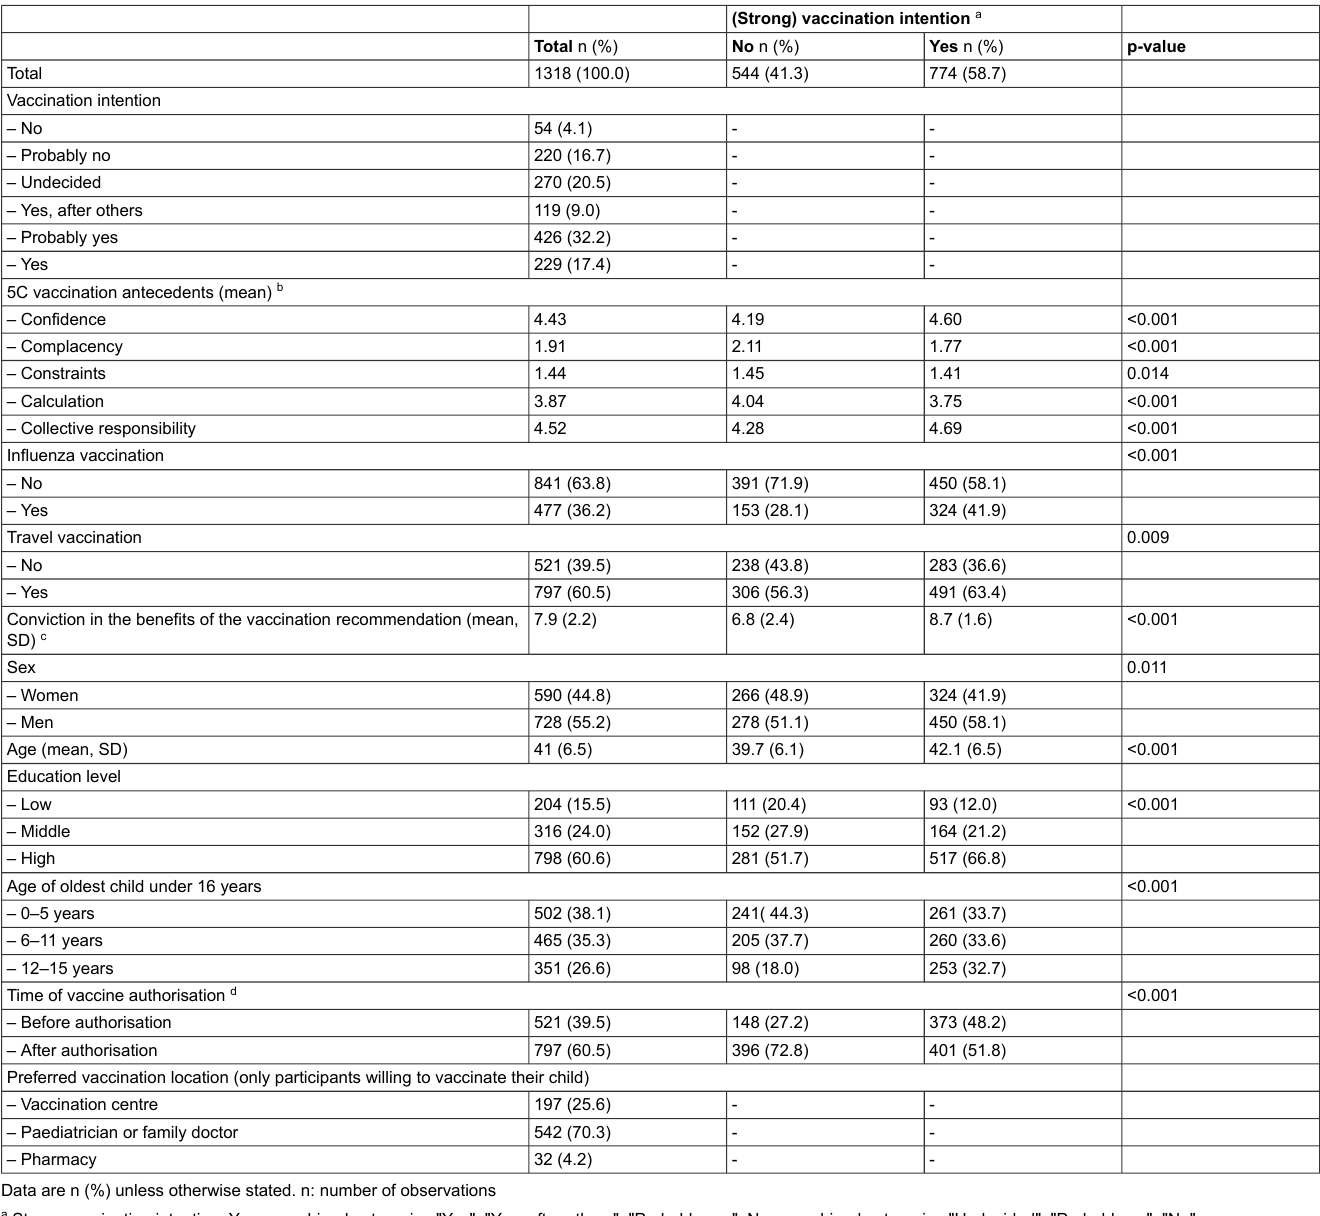
Table S1: Characteristics of the study population (n =